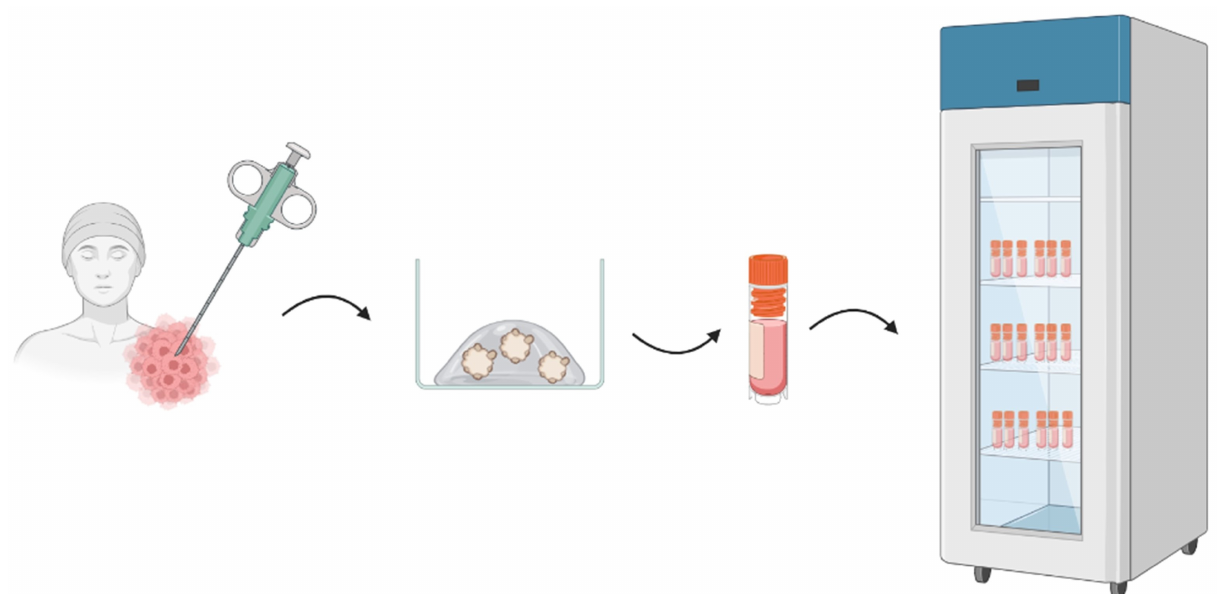
Figure 2. Schematic representation of development of a living biobank containing cancer